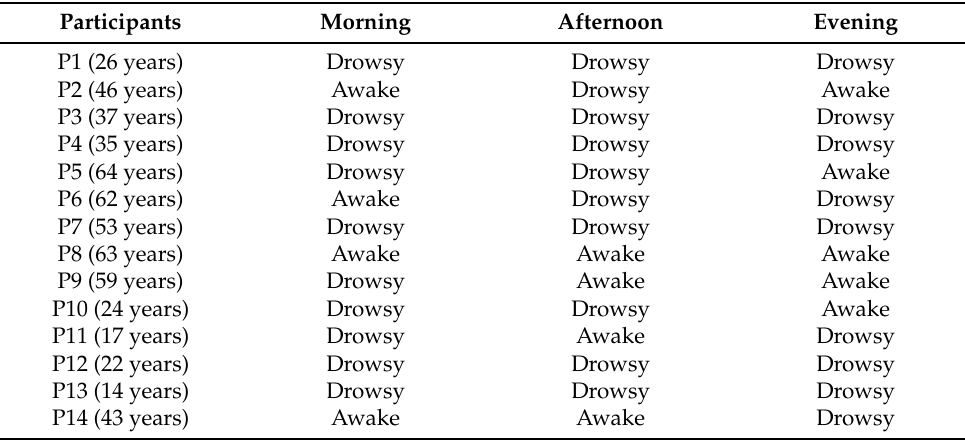
Table 5. Detailed table of each participant’s